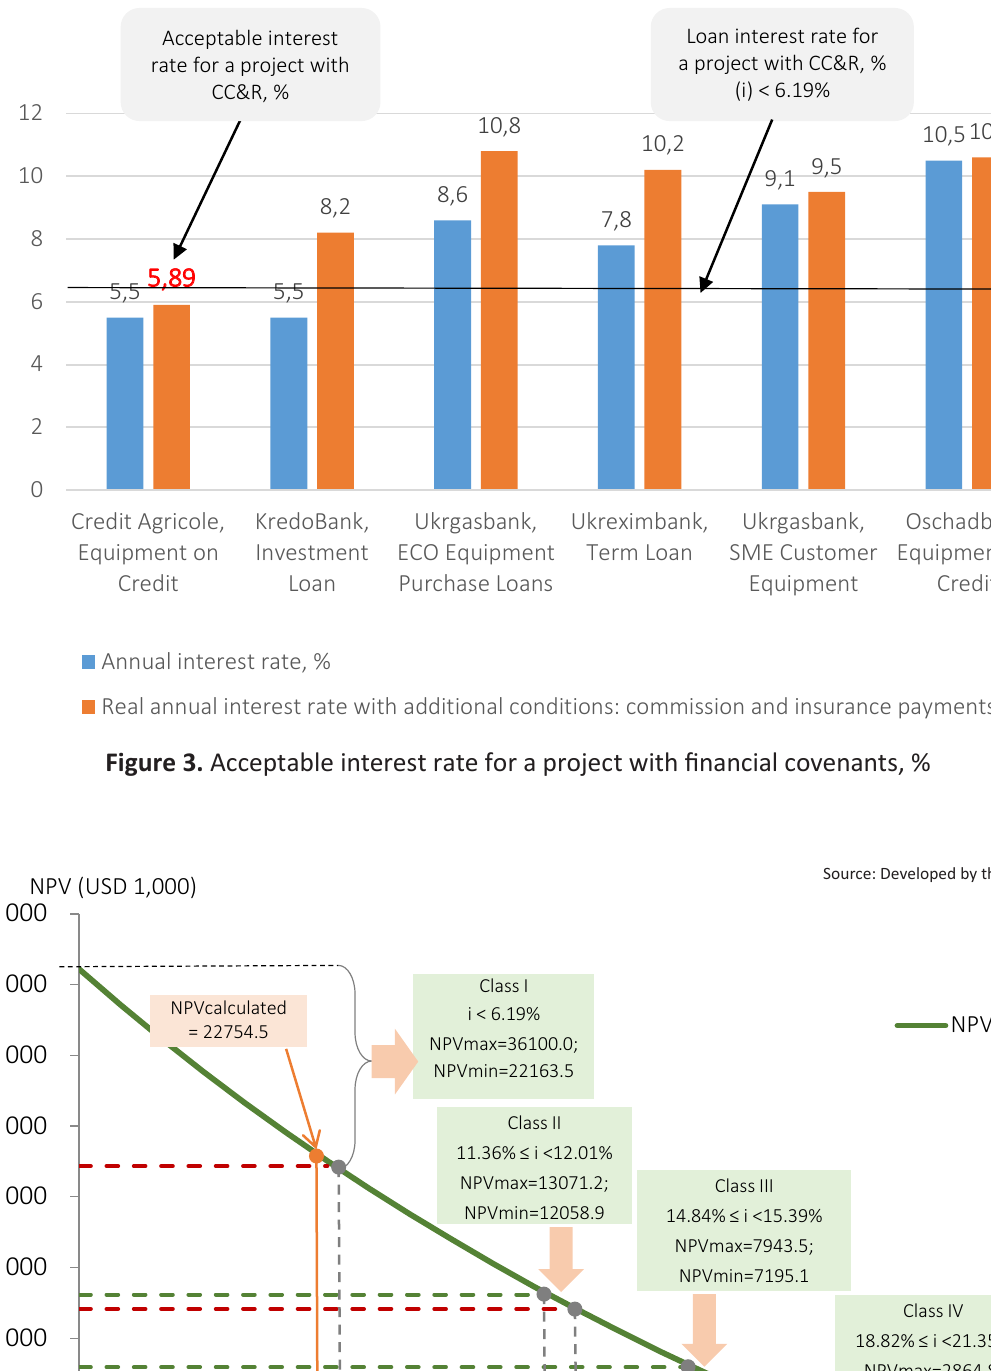
Source: Developed by the authors.